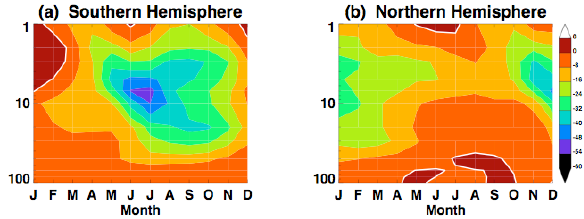
534 Figure 8 : Q – N differences in the subtropical N 2 O gradient [ppbv], as a function of 535 Fig. 8. Q − N differences in the subtropical N 2 O gradient (ppbv), as month and altitude in (a) the Southern Hemisphere and (b) the Northern Hemisphere. 536 a function of month and altitude in (a) the Southern Hemisphere and Negative differences indicate weakening of the sub–tropical mixing barrier i.e., 537 (b) the Northern Hemisphere. Negative differences indicate weak- enhanced sub–tropical mixing. White contours indicate zero difference. 538 ening of the subtropical mixing barrier (i.e. enhanced subtropical mixing). White contours indicate zero differences.